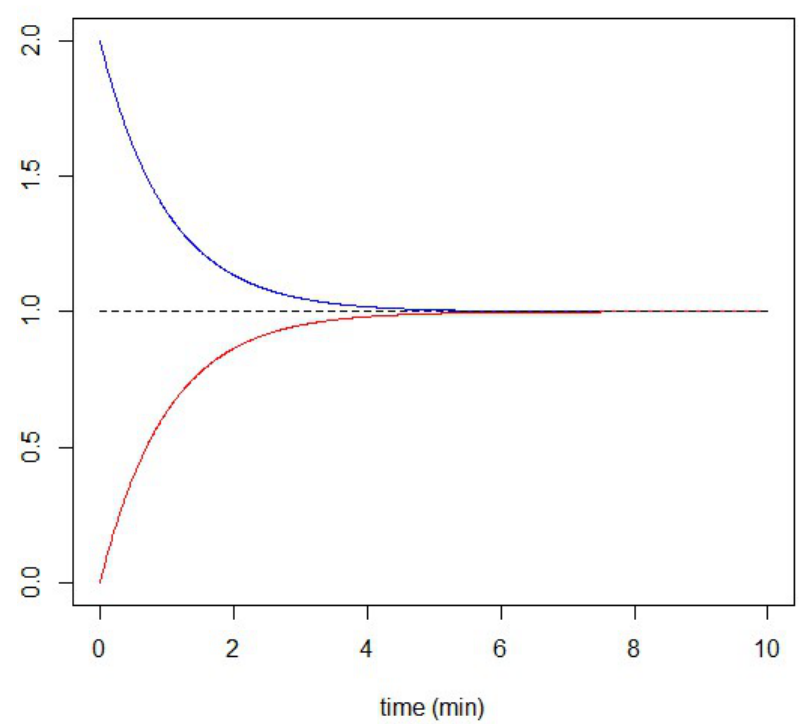
Figure 3. Illustration of the diffusion information for 2 nodes. The initial conditions are Γ = 0, f ( 0, x ) = f 0 ∈ R + , and f ( 0, y ) = 0. We set D = 1/2, and f 0 = 2. Blue is for f ( t , x ) , while red is for f ( t , y )